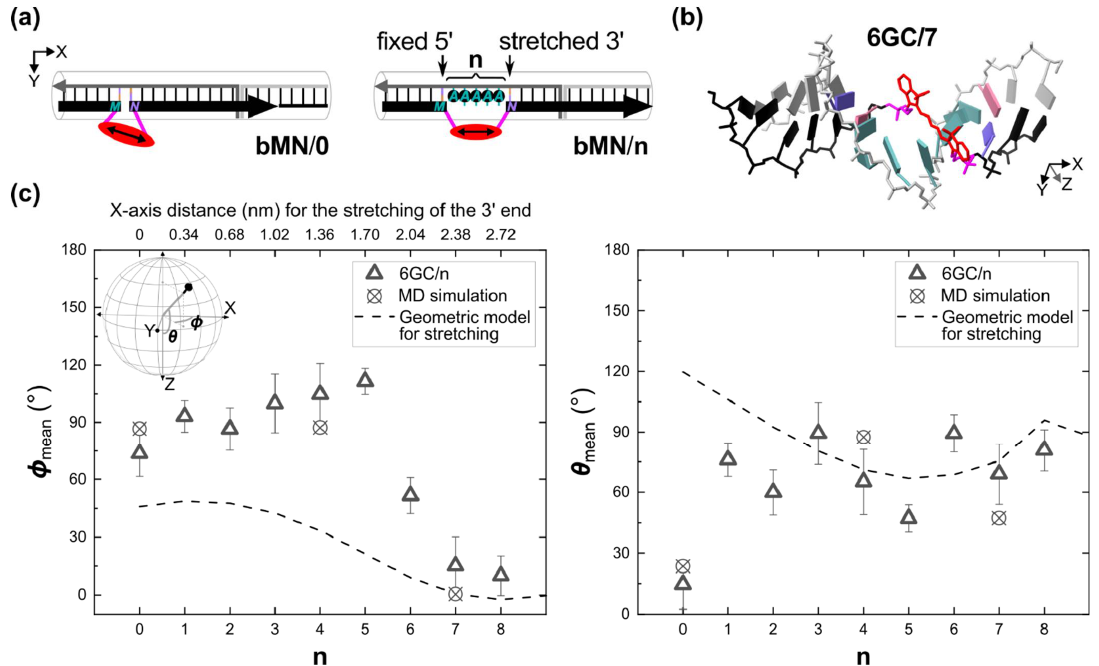
Figure 4. The effect of mechanical stretching on the spatial orientation of Cy5, as a function of the stretching level n . ( a ) Schematics for the mechanical stretching using the same DNA template de- picted in Figure 1 b . Stretching was done in a stepwise manner by introducing n number of unpaired adenine bases. Samples are labeled as bMN / n , where M and N were the dye’s flanking bases at the 5′ and 3′ ends, respectively. The positive sign indicates that the 5′-to-3′ direction of the Cy5-tethered strand runs along the positive X-axis (see Figure 1a). Left: Structure without stretching, bMN / 0 . Right: Structure with stretching. ( b ) MD simulation frame of 6GC / 7 . ( c ) Plots of ϕ mean vs n and θ mean vs. n for 6GC / n . The inset on the left shows again the coordinates for convenience. A geometric model (dash lines) was constructed based on the neighboring base pairs in a static DNA duplex (see Text S4.2). MD simulations for n = 0 , 4 , and 7 are shown as circles with x. Error bars are (cid:2026) = ±(cid:3493)(cid:2026) (cid:3051)∗ (cid:2026) (cid:3052)∗ , where (cid:2026) (cid:3051)∗ and (cid:2026) (cid:3052)∗ are the standard deviations of the elliptical cone with the center in the mean direction in the framework of the Kent (Fisher-Bingham) distribution [59].